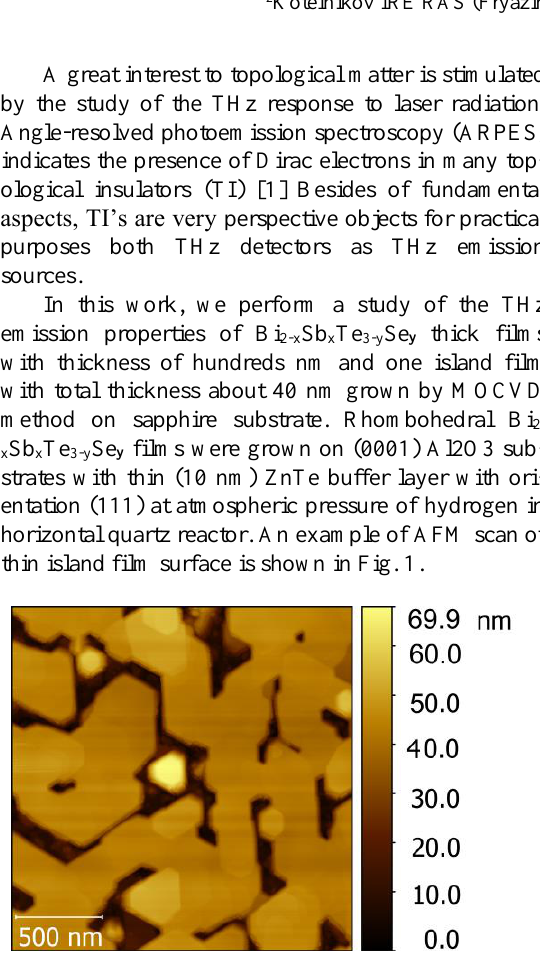
Fig. 1. AFM scan of the TI island film’s surface